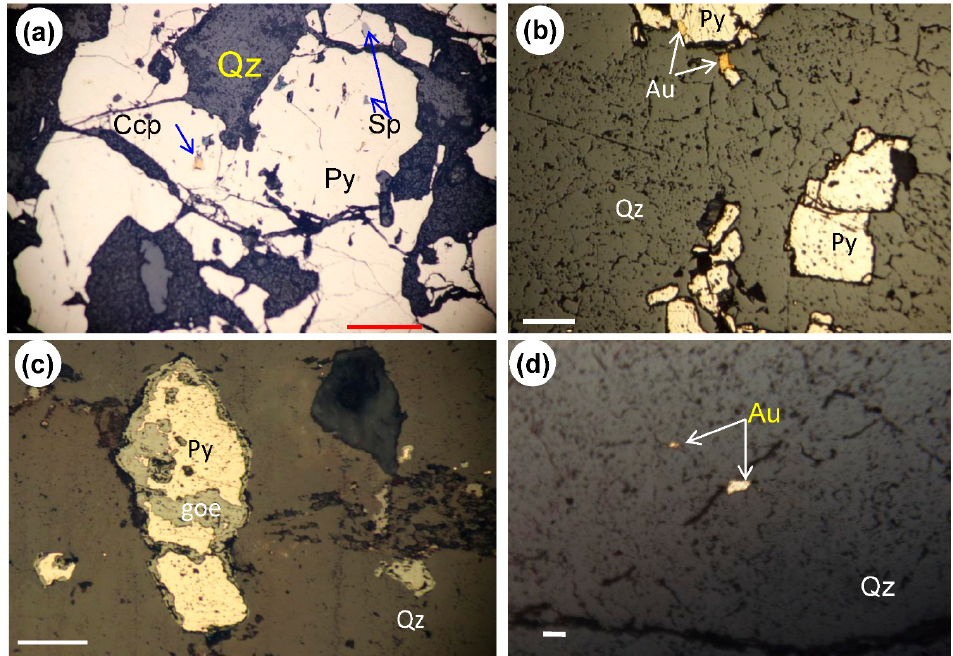
Figure 12. Photomicrograph of mineralized quartz vein of Sir Bakis mine in reflected light (//N); ( a ) inclusions of chalcopyrite and sphalerite in pyrites; quartz vein (Sr#1), scale 0.3 mm; ( b ) gold associated with pyrite in mineralized quartz vein (scale 0.15 mm; Sr–30); ( c ): pyrite (py) may replace by geothite (goe) in quartz (Qz) vein, 0.2 mm; ( d ) gold inclusions in quartz (Sr6: 0.1 mm).